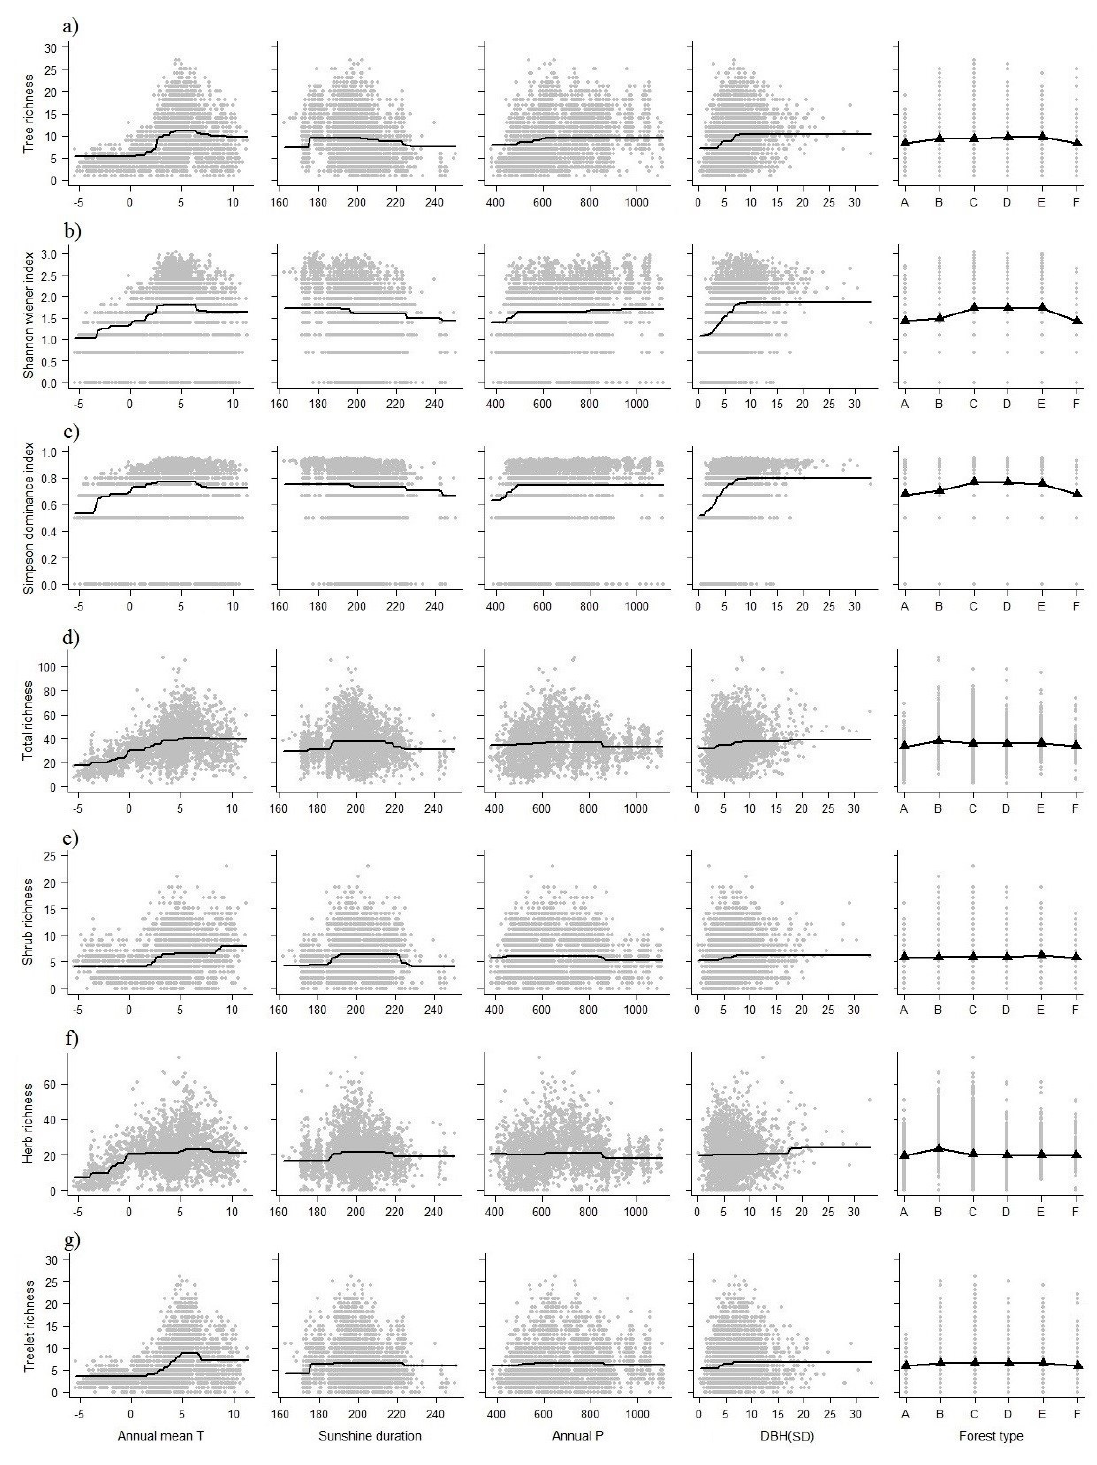
Figure 5. Relationships between plant richness and predictors. ( a ) Tree richness, ( b ) tree Shannon diversity index, ( c ) Simpson dominance index, ( d ) total richness, ( e ) shrub richness, ( f ) herb richness, and ( g ) treelet richness. T, temperature; P, precipitation.